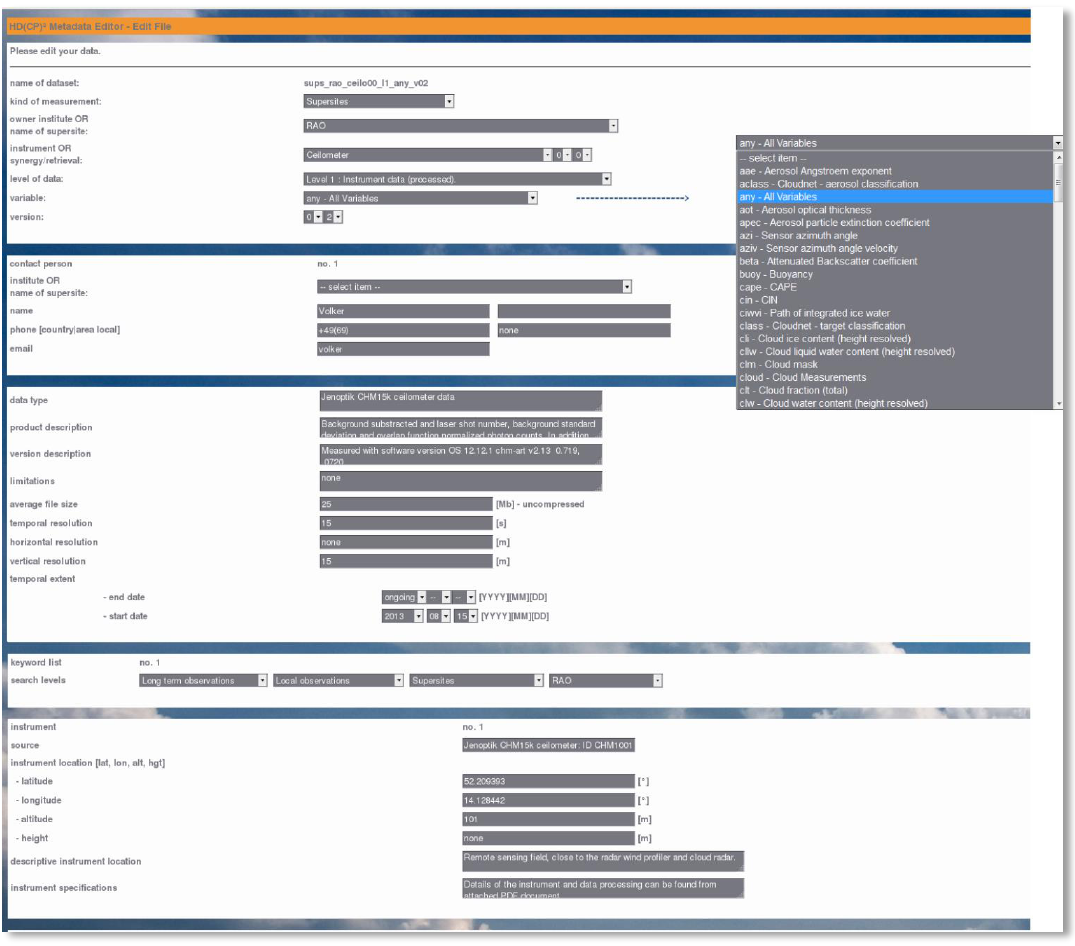
Figure 3. The metadata editor.